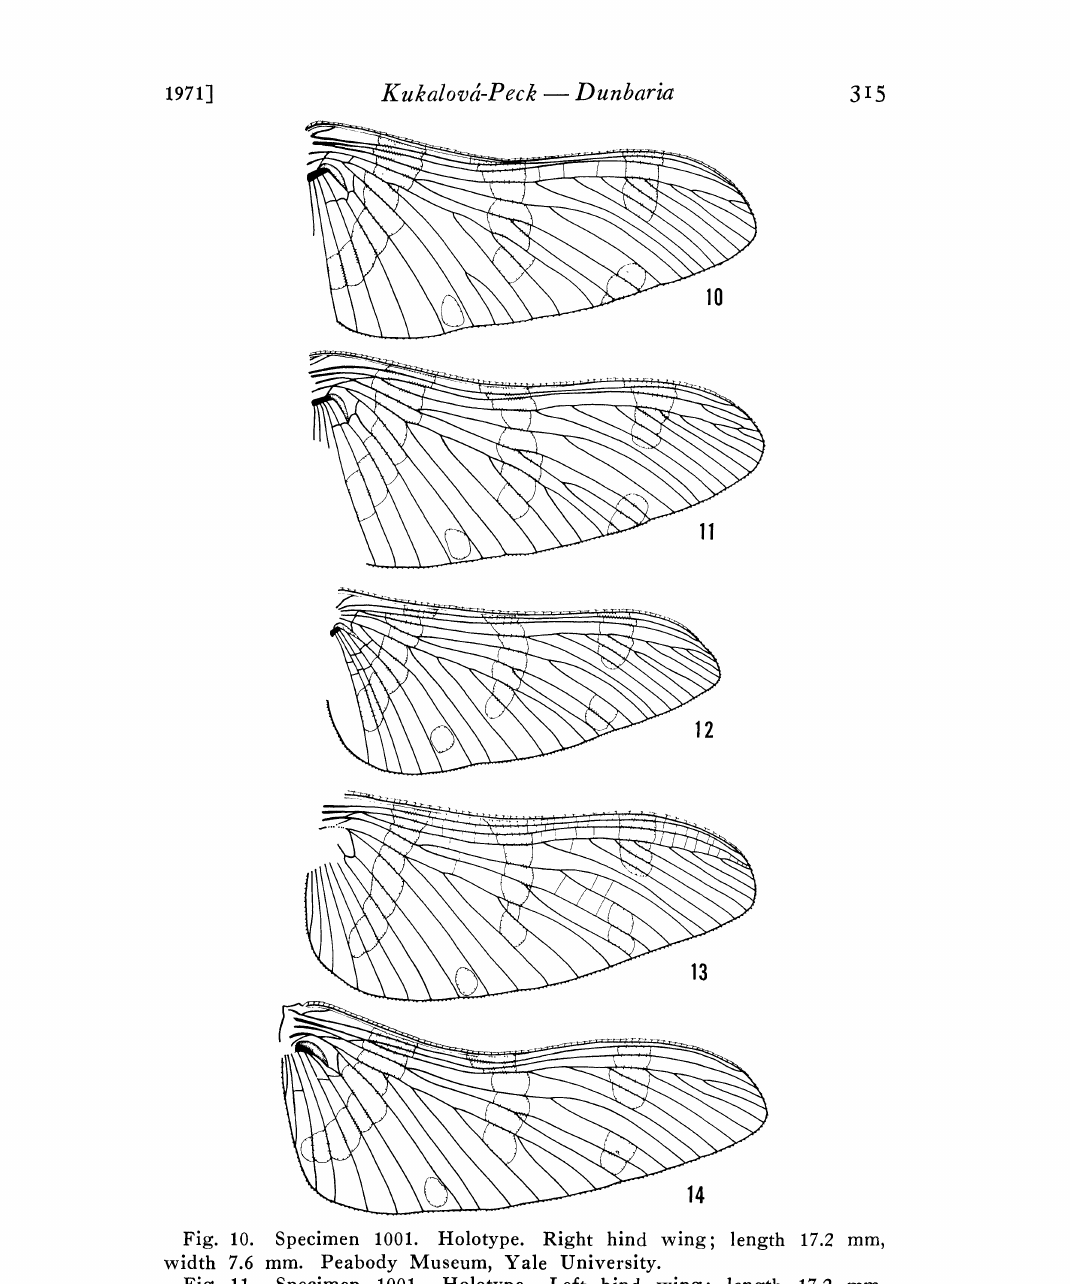
Fig. 10. Specimen 1001. Holotype. Right hind wing; length 17.2 mm, width 7.6 mm. Peabody Museum, Yale University. Fig. 11. Specimen 1001. Holotype. Left hind wing; length 17.2 mm, width 7.6 mm. Peabody Museum, Yale University. Fig. 12. Specimen 1002. Right hind wing; length 17 mm, width 7.6 mm. Peabody Museum, Yale University. Fig. 13. Specimen 5021. Right hind wing; length 17.2 mm, width 7.2 mm. Peabody Museum, Yale University. Fig. 14. Specimen 3058. Right hind wing; length 17.9 mm, width 6.6 mm, Museum of Comparative Zoology, Harvard